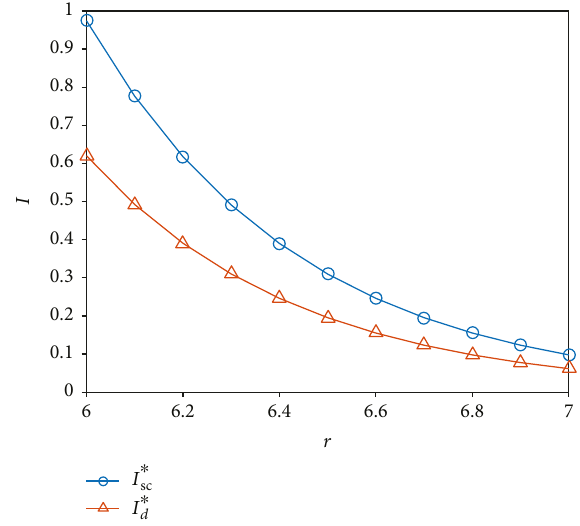
Figure 1: E ff ect of rainfall on the level of optimal agricultural